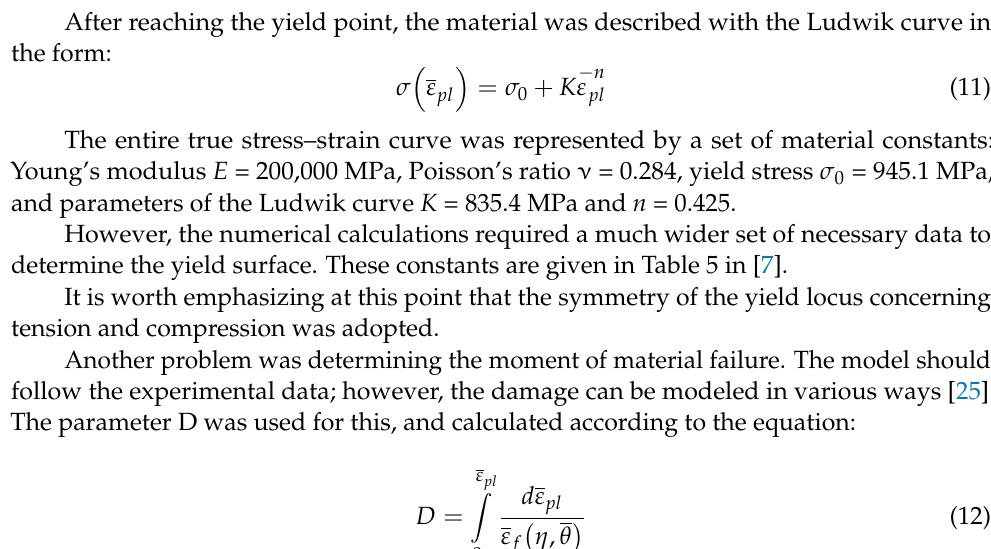
Figure 4. Comparison of engineering and true stress – strain curves (source: own computations).